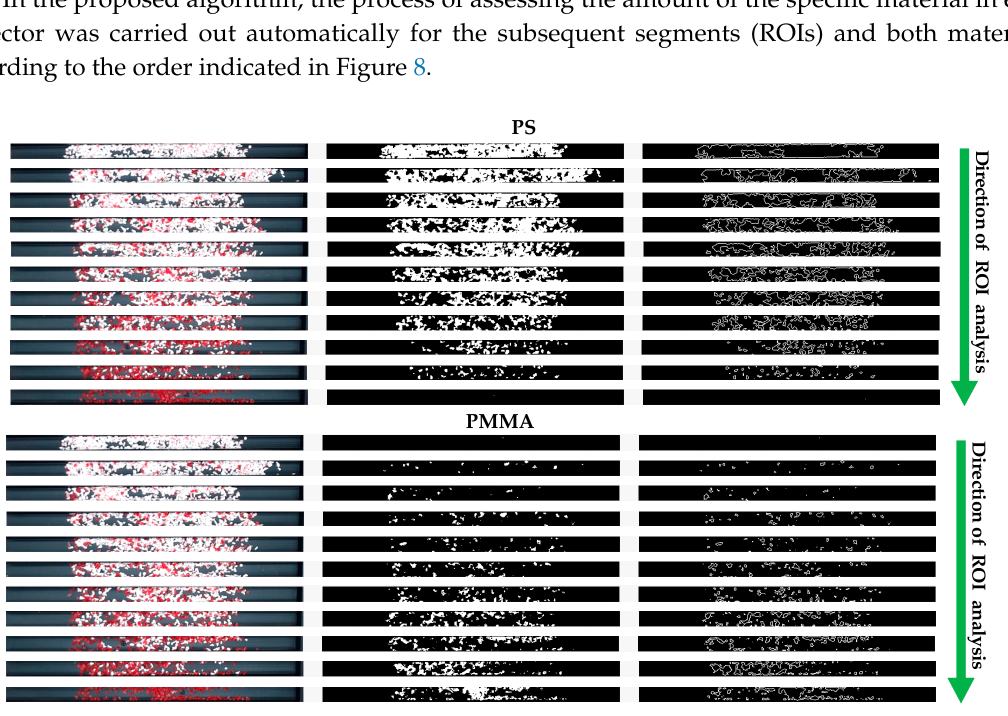
read from the camera refer to the samples mixed by weight.